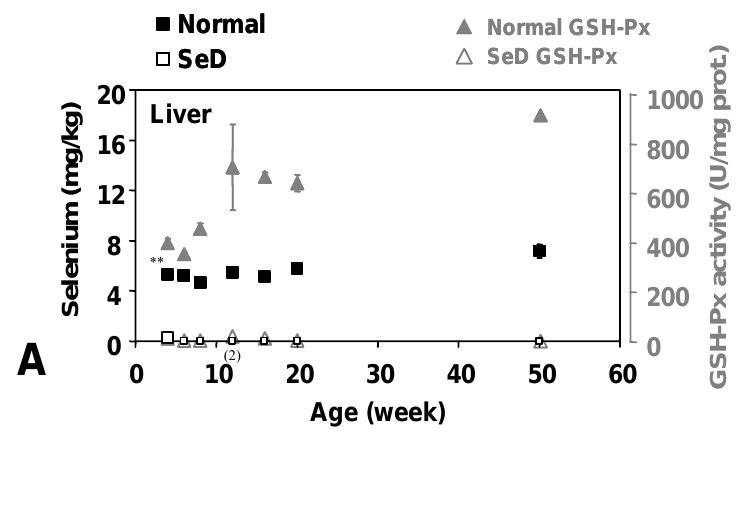
Figure 3. Dependence of Se contents in the (A) liver, (B) kidney, and (C) spleen of normal and SeD rats on the age of rats. Values are indicated as the mean ± SD of three samples. Numbers in parentheses indicate the number of samples when number of samples measured were less than 3. * , *’ , and ** indicate significant difference between normal and SeD groups at p < 0.05, p < 0.01, and p < 0.001, respectively. Gray closed and open triangles in (A) indicate GSH-Px activity in normal and SeD rat liver, respectively. Values are indicated as the mean ± SD of 3 samples. GSH-Px activities of SeD groups were significantly lower than that of normalgroup by p < 0.001 for all